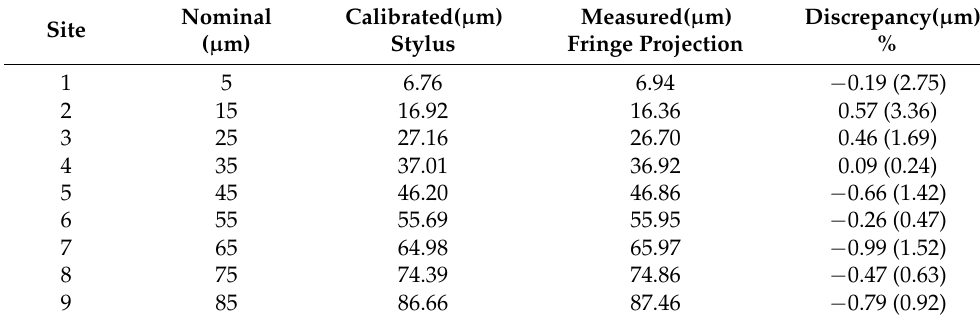
Table 1. Calibrated step heights of the reference standard.